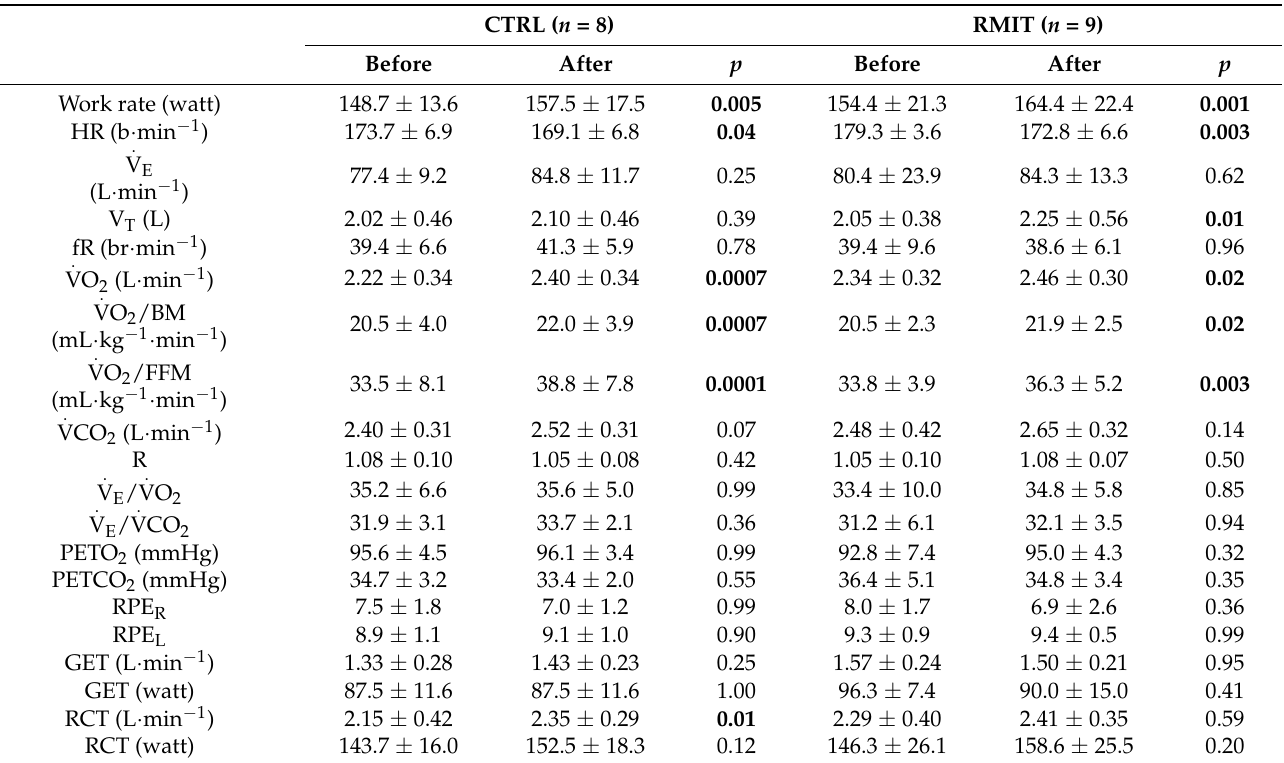
Table 3. Peak values of the main investigated variables, determined at exhaustion during the incremental exercise, before and after the standard intervention of body mass reduction combined with a control training and with RMIT. CTRL ( n = 8) RMIT ( n = 9) Before After p Before After p 148.7 ±